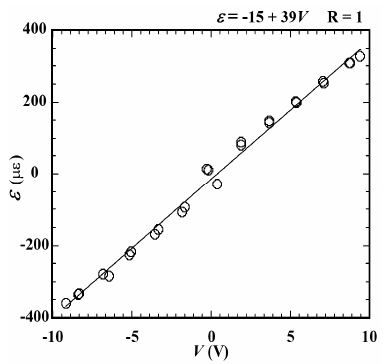
Figure 8. Master curve of strain vs. voltage.